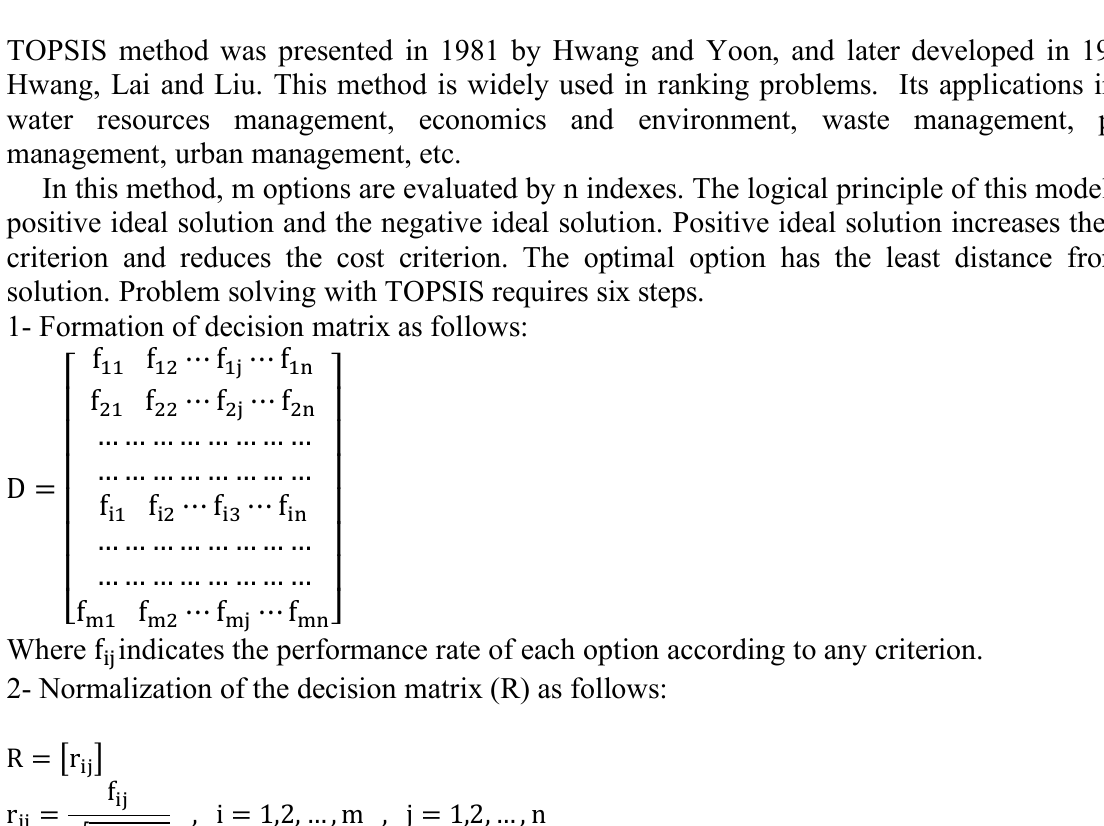
Figure 4 . Sample chromosomes in the optimization algorithm TOPSIS decision-making